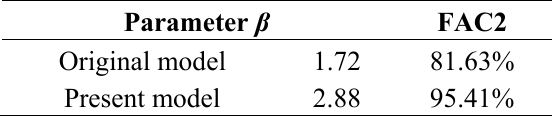
Table 1. C max model versus observation performance for Δτ = Δτ 0